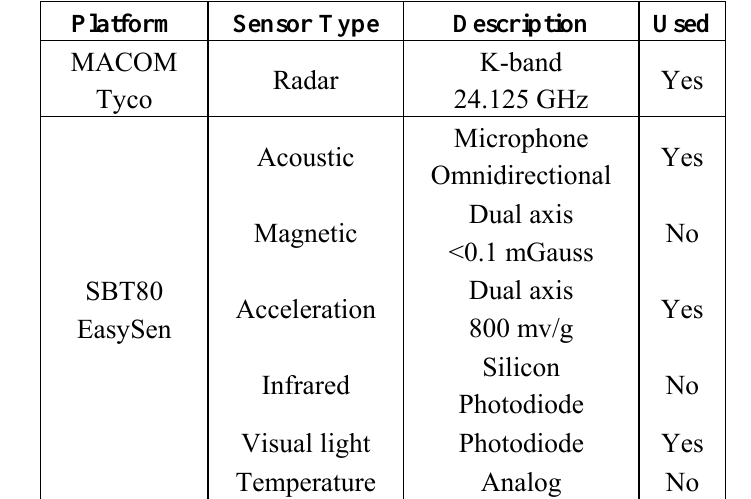
Table 2. Overview of the sensor modes of the distributed sensor